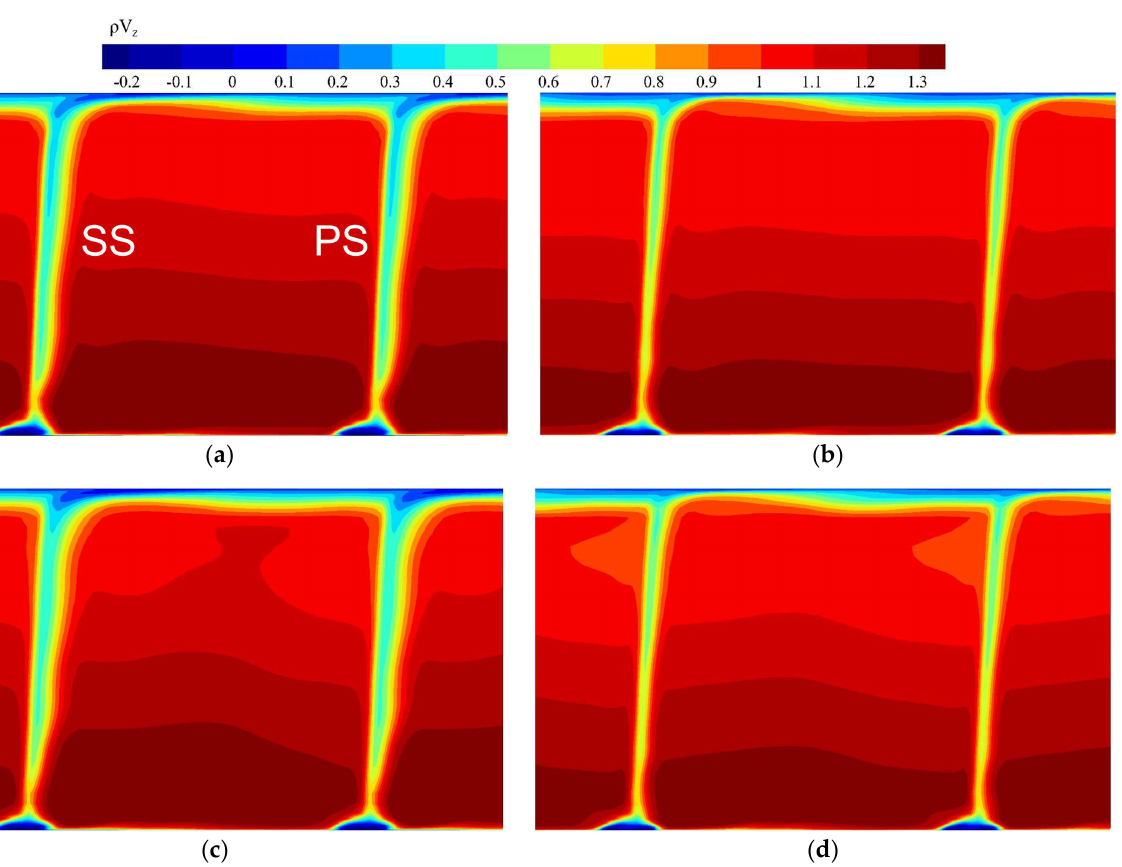
Figure 7. Comparison of blockage coefficient in three regions at the rotor outlet.